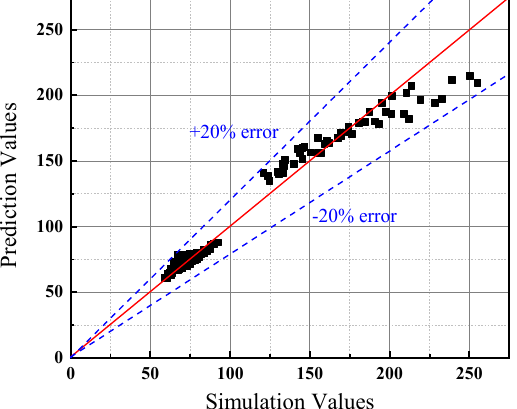
T Δ values and the predictions by Equation qx